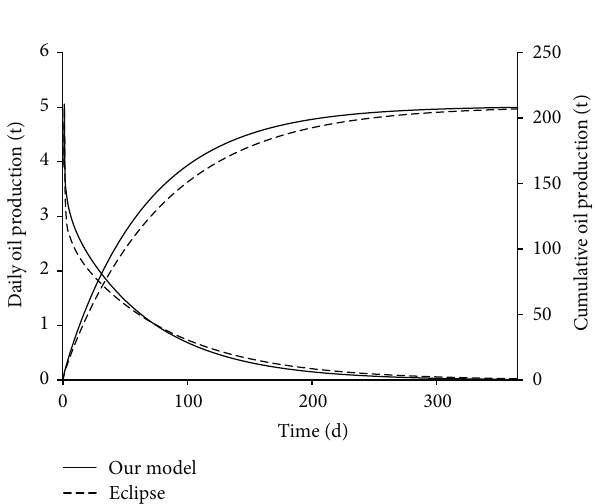
Figure 2: Flow rate comparison between the proposed model and Eclipse for one year of